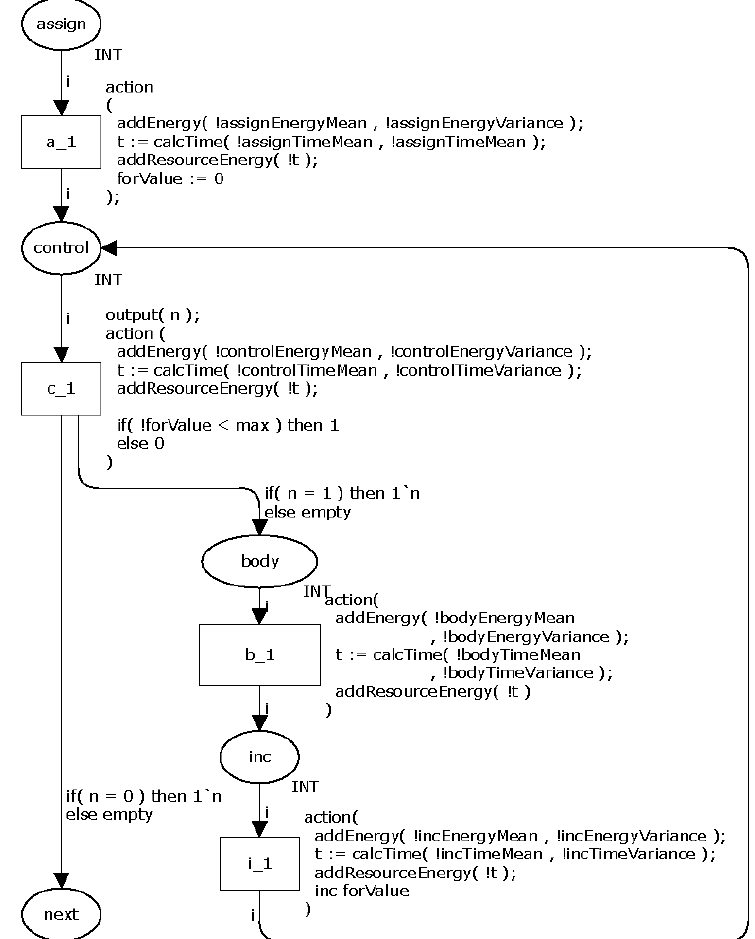
Figure 7. CPN model of the command for